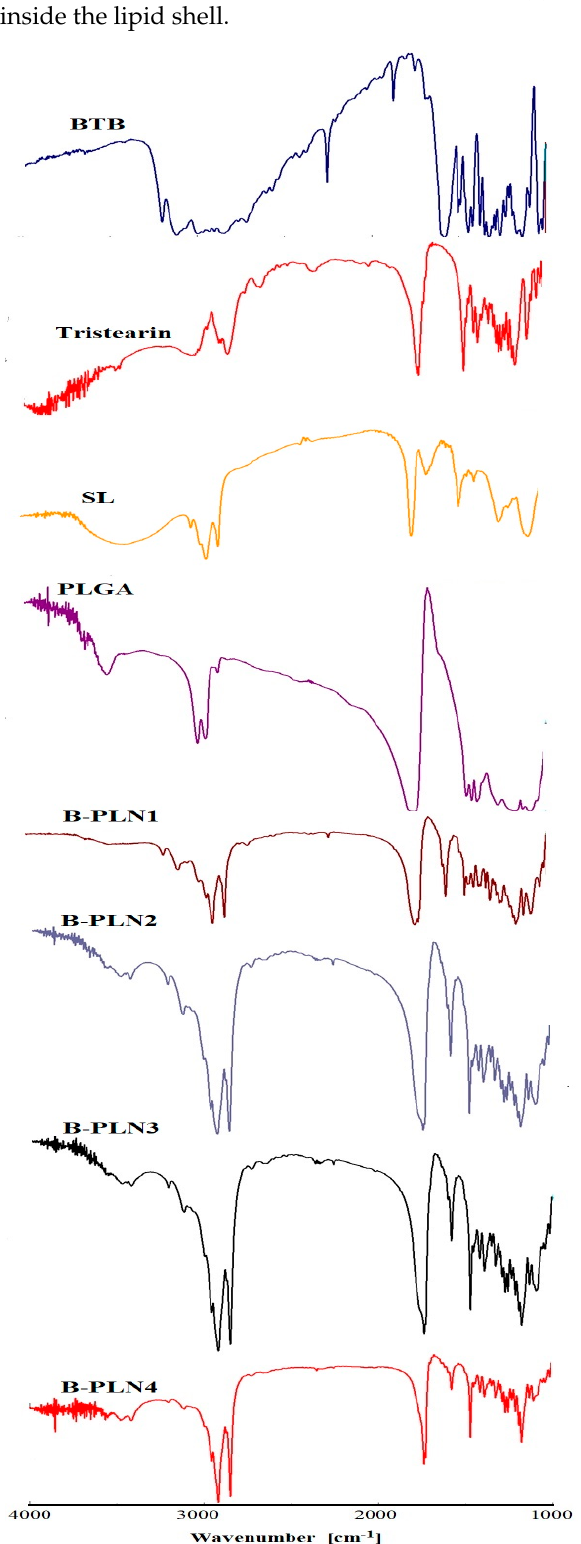
Figure 2. Comparative FTIR spectra of BTB, stearin, PLGA, SL and formulated lipid-polymer nanoparticles (B-PLN1 to B-PLN4).